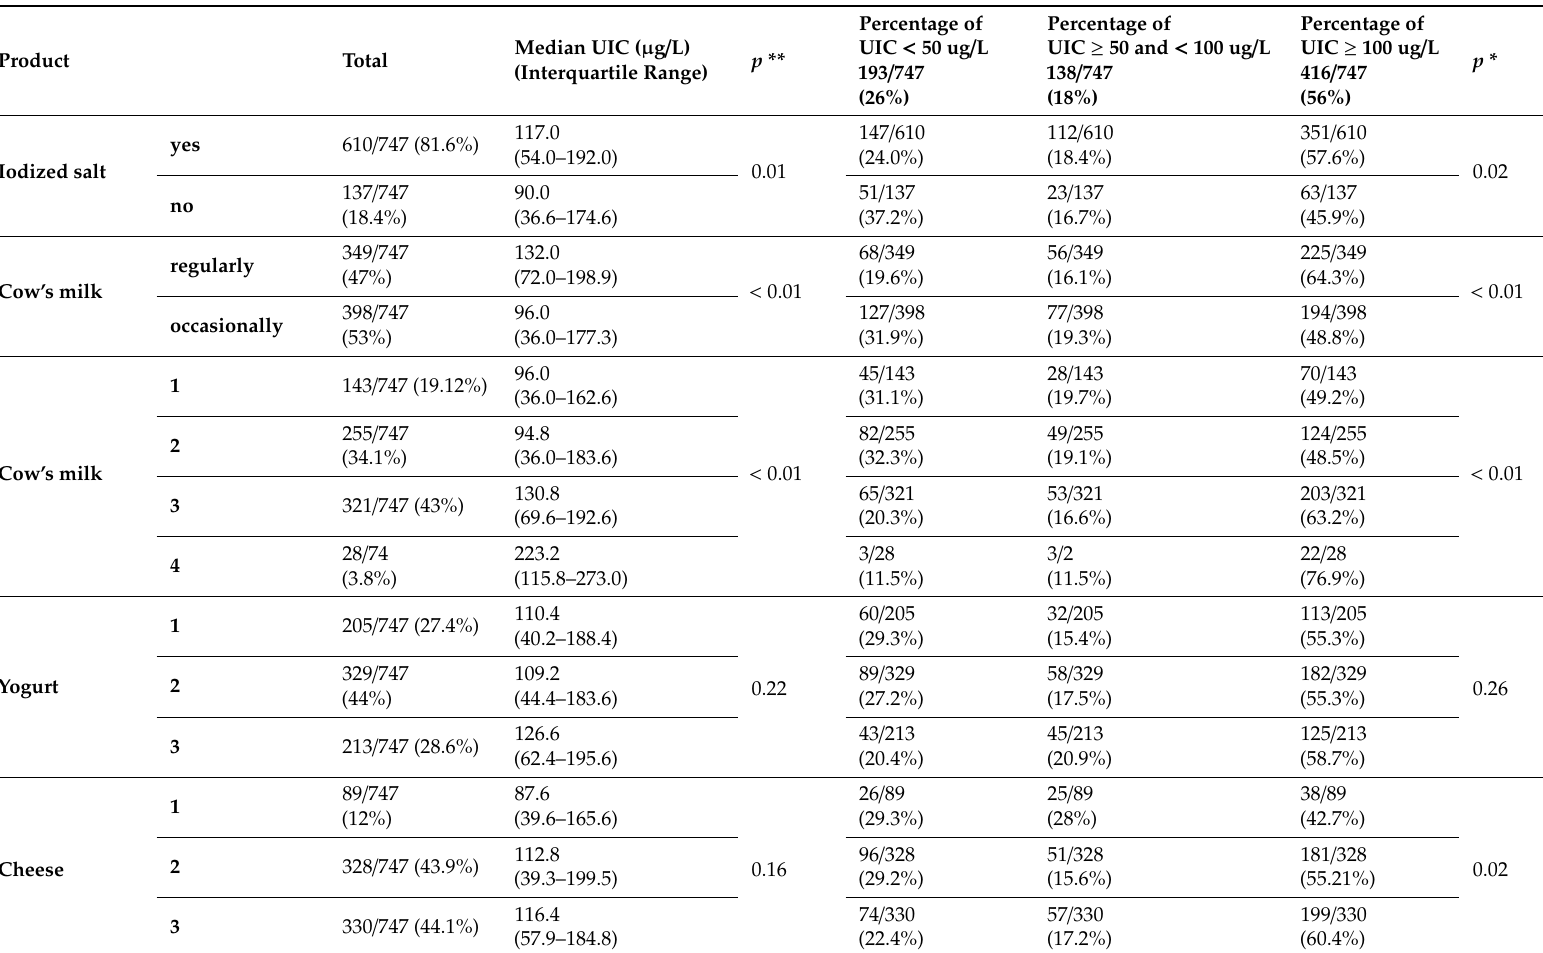
Table 2. School-age children’s reported eating habits and urinary iodine concentration (UIC) adequacy (on the right, divided for the percentage (%) of samples with a UIC ≥ 100 µ g / L, between 50 µ g / L and < 100 µ g / L and < 50 µ g / L) and the corresponding median UIC in the whole sample (on the left) according to iodized salt use and food milk, yogurt, and cheese consumption